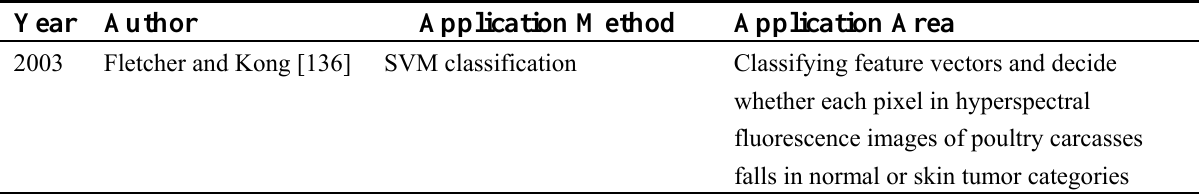
Table 2. Papers and reports on applications of SVMs in agricultural